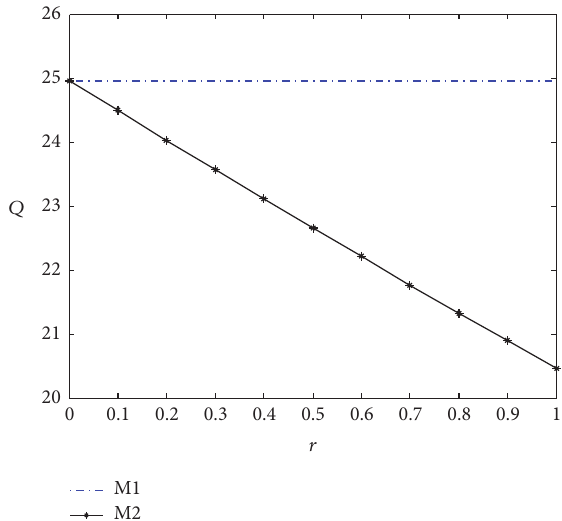
Figure 5: Optimal order quantity comparison in models M1 and M2.